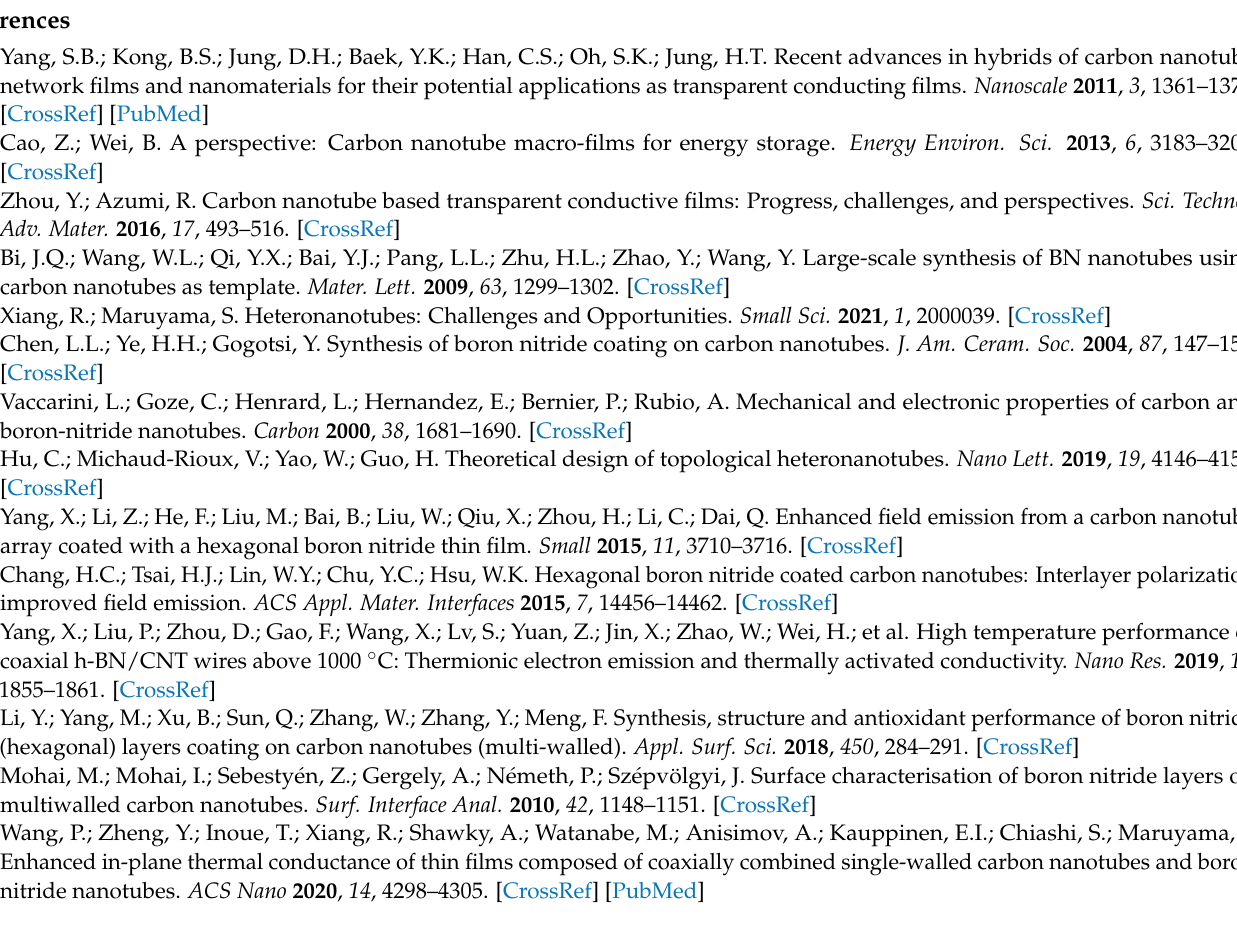
Figure S4. TEM images of (a) SWCNT film after 60 s-plasma treatment, (b) SWCNT@h-BN film obtained using SWCNTs shown in (a) as a template; Figure S5. TEM images of the SWCNT@h-BN were synthesized at different temperatures of (a)900 ◦ C, (b) 1000 ◦ C, and (c) 1100 ◦ C.; Figure S6. TEM images of SWCNT@h-BN grown from SWCNTs without plasma treatment; Figure S7. TEM images of the SWCNT@h-BN experienced growth times of (a) 5 min, (b) 15 min, (c) 30 min, and (d) 120 min; Figure S8. D and G bands Raman spectra of the SWCNT@h-BN synthesized using SWCNT templates experienced different plasma treatment time as a